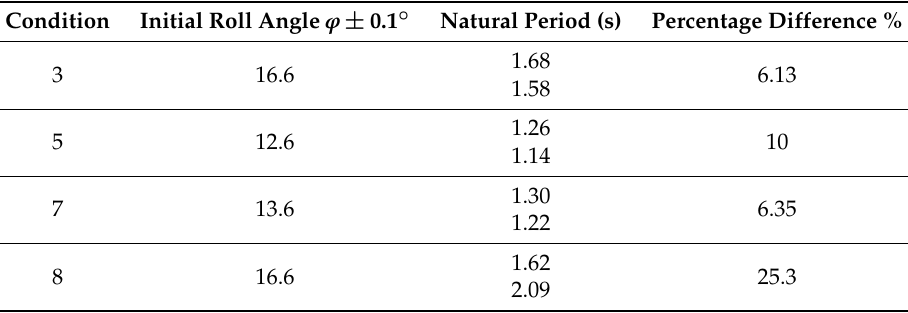
Table 4. Natural decay period for conditions with the same initial roll